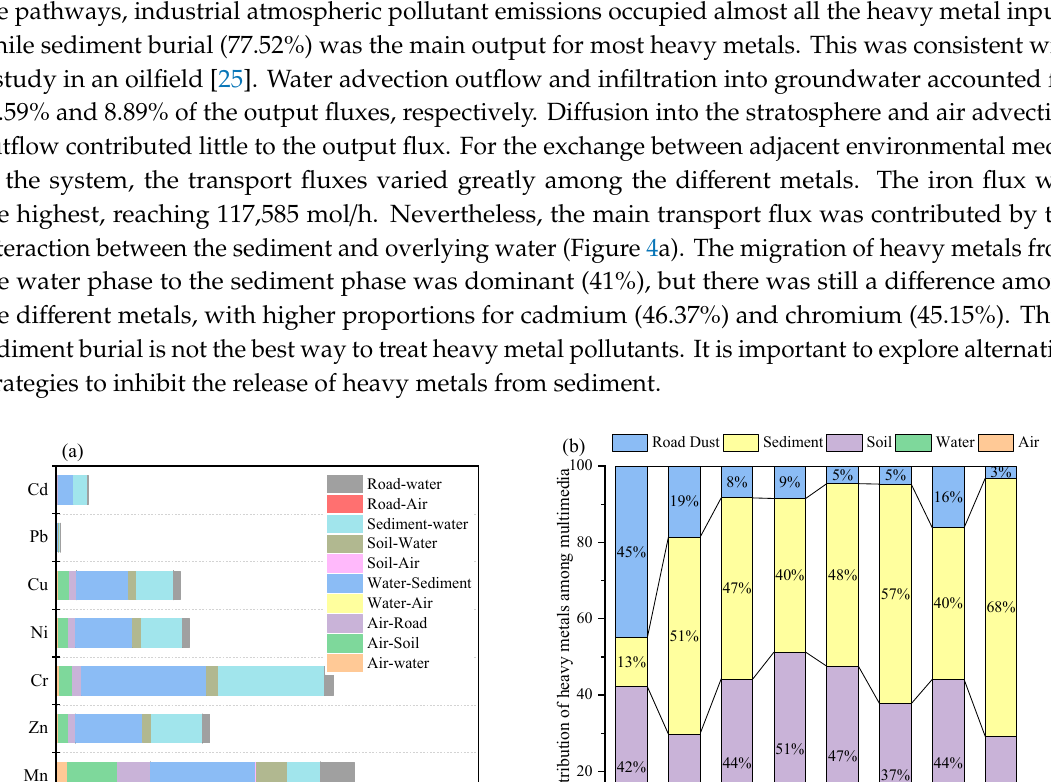
Figure 3. A comparison of the simulated and observed heavy metal concentrations in the compartments .